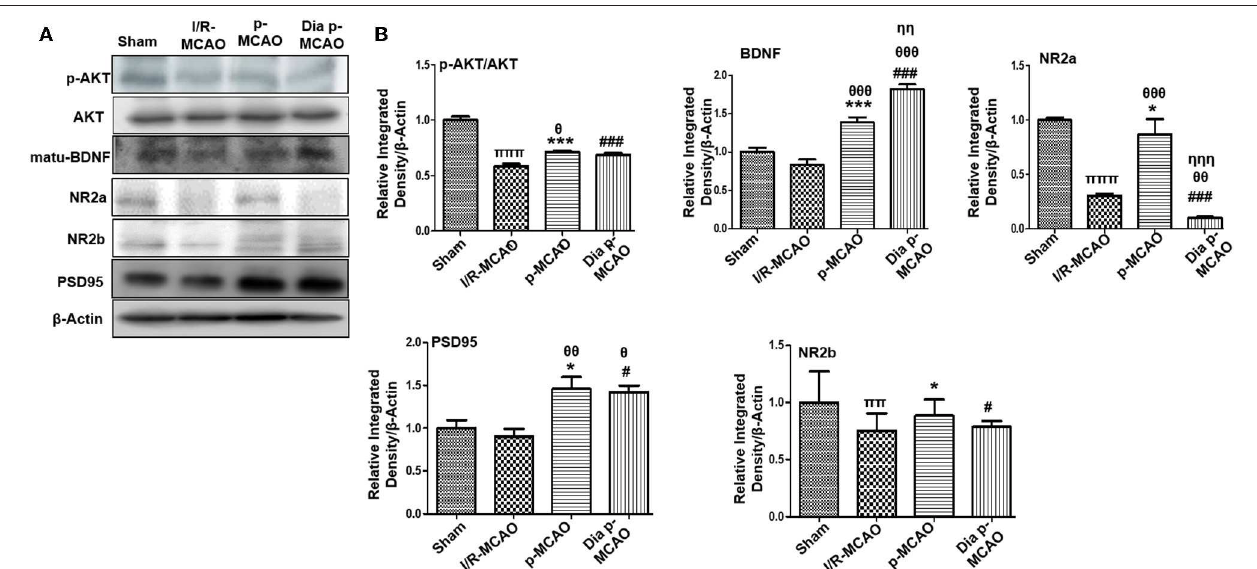
FIGURE 2 | Effect of ischemia on NMDA receptor related molecule changes (A) Representative Western blot of p-AKT, AKT, matu-BDNF, NR2a, NR2b, PSD95. (B) Histograms indicating comparative expression of various glutamate receptors in hippocampus. Densitometric analysis was expressed in relative to β -Actin ( n = 5/group). * p < 0.05, # p < 0.05, and π p < 0.05 relative to sham group. θ p < 0.05 relative to I/R MCAO, η p < 0.05 between p-MCAO and Dia p-MCAO. *** p < 0.001 and ### p < 0.001. ππ shows significant difference of I/R MCAO to sham, and its value is p < 0.01, πππ shows significant difference of I/R MCAO to sham, and its value is p < 0.001, θθ shows significant difference of p-MCAO and Dia p-MCAO to I/R, and its value is p < 0.01, θθθ shows significant difference of p-MCAO and Dia p-MCAO to I/R, and its value is p < 0.001, ηη shows significant difference between p-MCAO and Dia p-MCAO, and its value is p < 0.01, ηηη shows significant difference between p-MCAO and Dia p-MCAO, and its value is p <